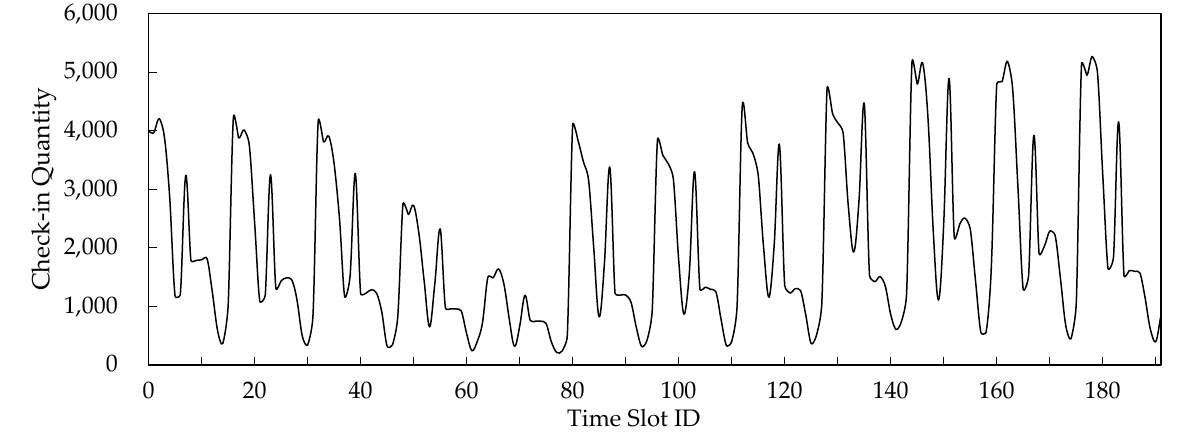
Figure 12. The distribution of check-ins for 192 time slots.